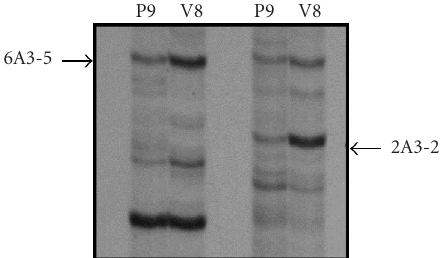
Figure 1. A representative di ff erential display (DD) analysis showing up- and downregulated genes. Total RNA was extracted from synthetic (P9) and proliferating (V8) SMC, then subjected to DD analysis. Migration of PCR products on a denaturing 6% polyacrylamide gel for 2 di ff erent primer pairs is shown. Each primer pair gives similar RNA fingerprinting between the 2 cell types. The di ff erentially expressed bands, having an altered ex- pression, were cut from the gel and reamplified. Lanes corre- spond respectively to synthetic (P9) and rapidly proliferating cells